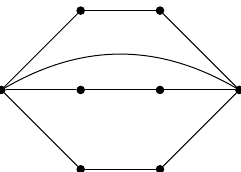
) = α ( G ) for all representations R , and ( left ) we have s ( R, G 1 1 1 ) = α ( G ) + 1 for all representations R ( right ) we have s ( R, G 2 2 2